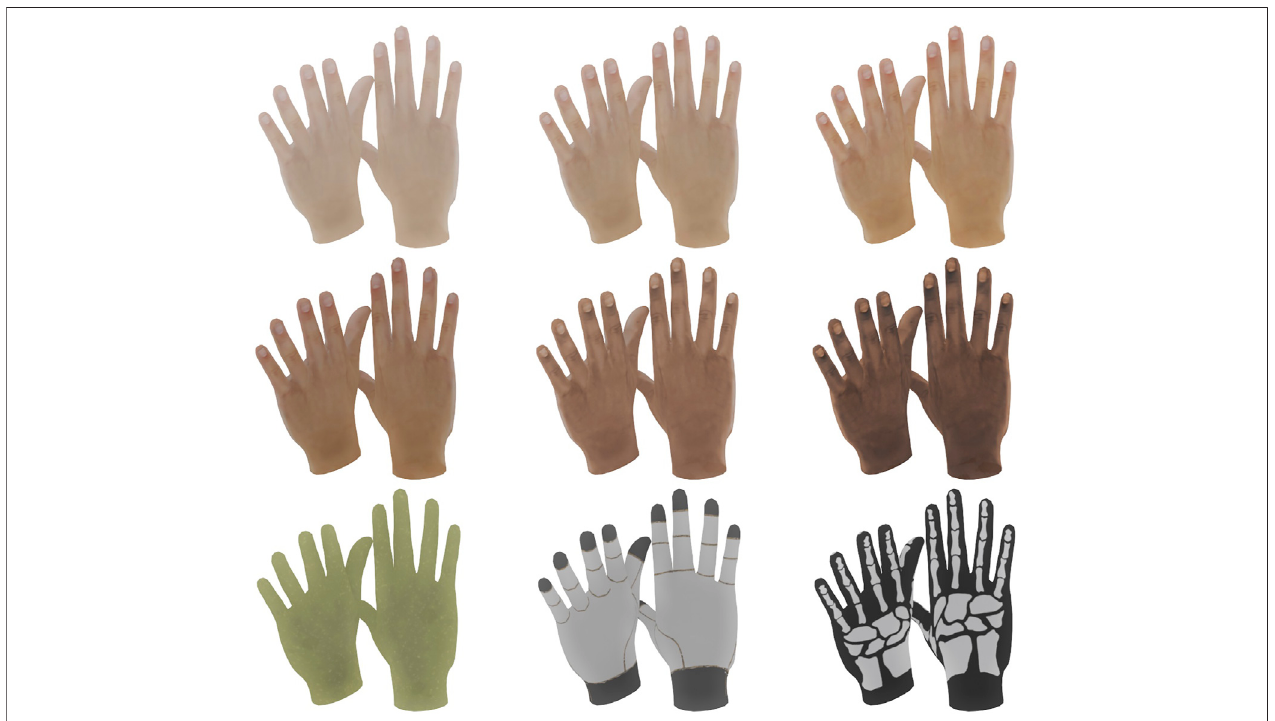
FIGURE 1 | We provide nine different hand textures: six skin-tone variants, an alien, a robot, and a skeleton hand. The skin-tone variants are designed to look realistic, while the non-human hands are more